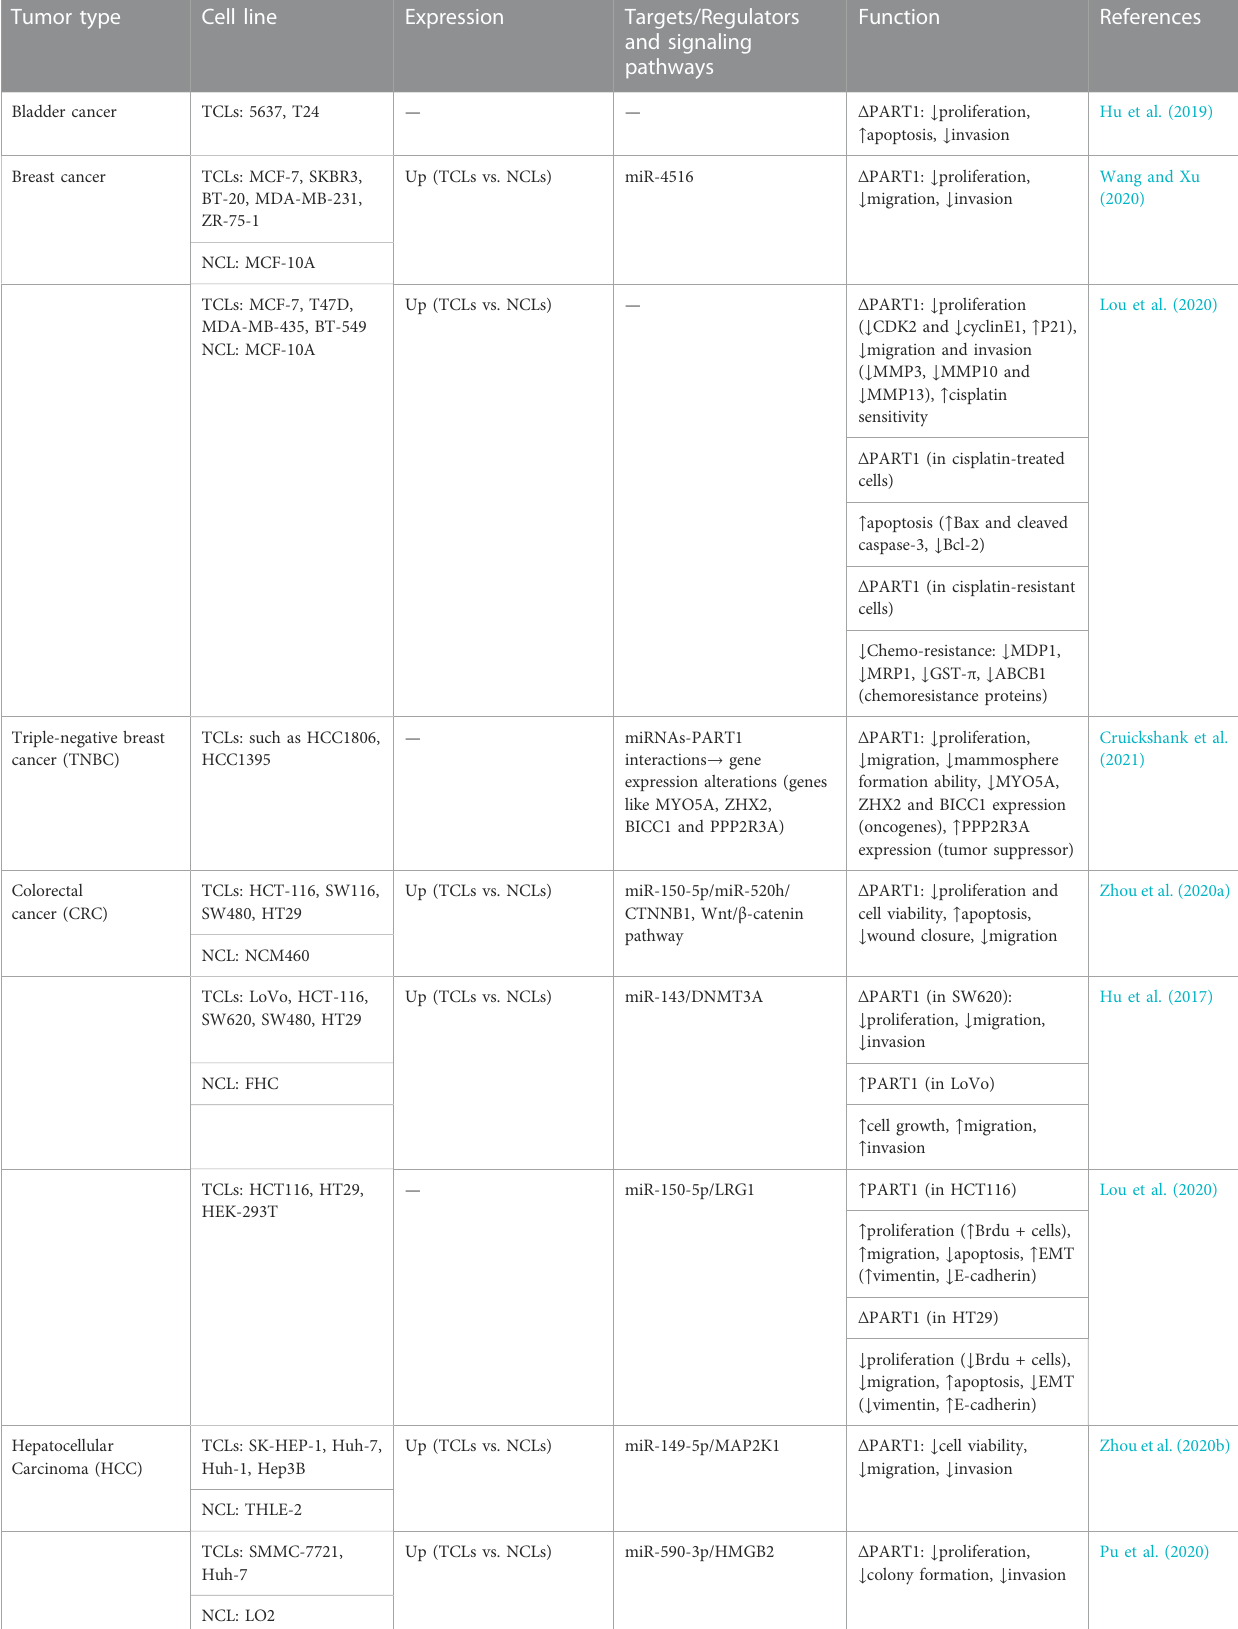
TABLE 1 In vitro experiments to examine expression and function of PART1 in malignancies in which PART1 has been up-regulated (TCLs: tumor cell lines, NCL: normal cell line, Δ : knockdown or deletion, EMT: epithelial-mesenchymal transition, Brdu: Bromodeoxyuridine, DDP: cisplatin, ↑ : increase, ↓ : decrease). Tumor